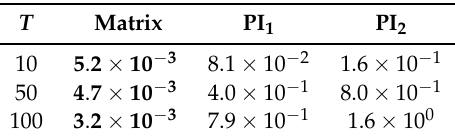
Table 5. Comparison of execution time for the matrix approach and the product integration (PI) methods for computing the approximate solution at T for α =